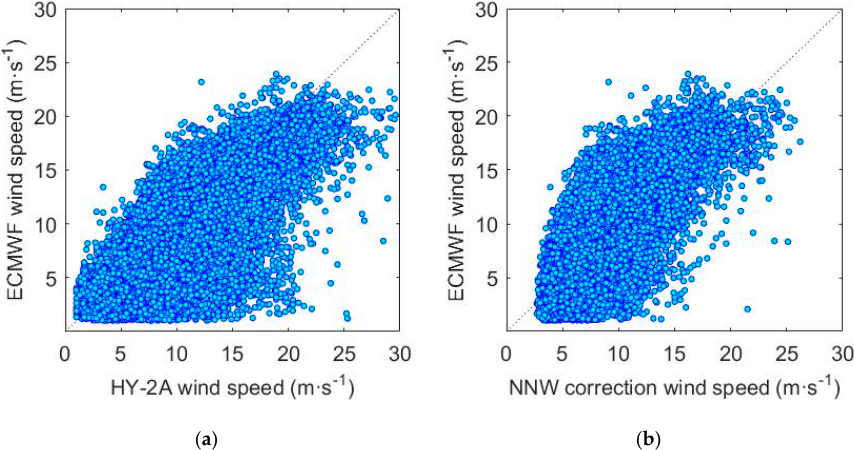
Figure 8. Scatter plot of HY-2A wind speed and NNW wind speed with ECMWF wind speed. ( a ) for HH polarization; ( b ) for VV polarization. The dashed line in this figure is the diagonal line.